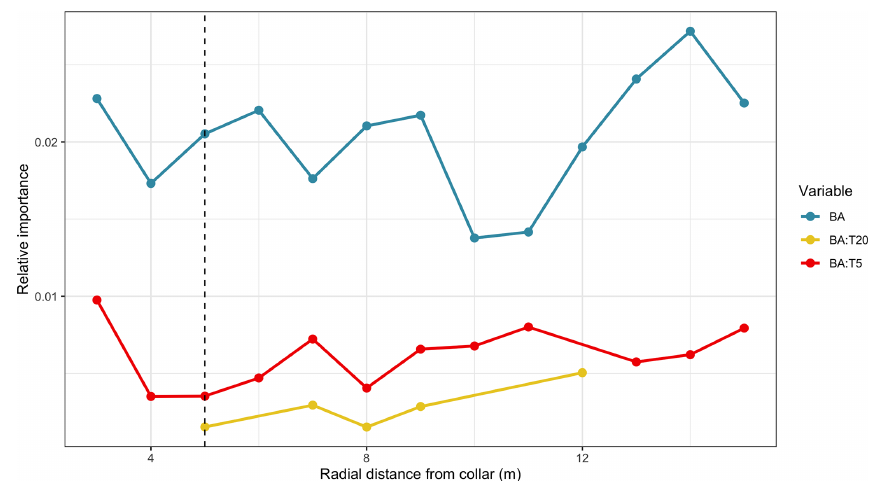
Figure 5. Test of robustness of results, run at various distances from soil respiration measurement collars ( x axis). Lines show the variable importance (calculated as R 2 partitioned by averaging over orders; see Methods) of basal area (BA), as well as the interaction of BA and temperatures at 5 and 20cm ( T 5 and T 20 respectively). Vertical dashed line shows the 5m radius used in Table 3 and Fig. 4 results. Note that the missing BA: T 20 (in yellow) dots at distances < 5 and > 12m mean that the terms were dropped from the model and are thus not significant.